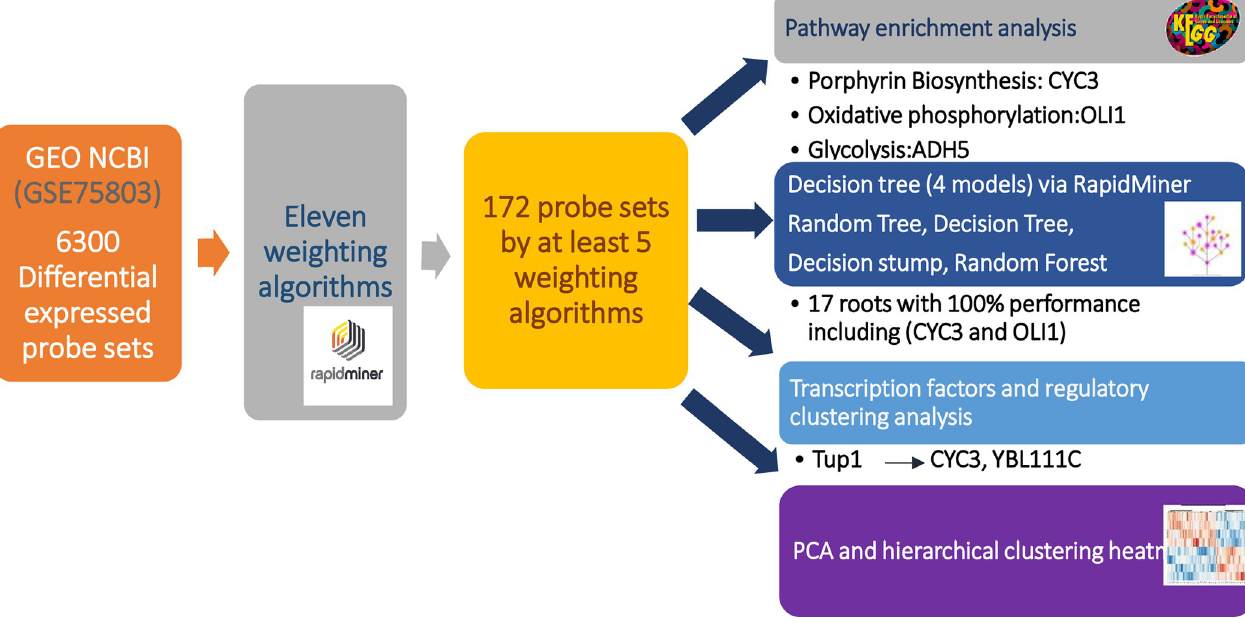
PLOS ONE | https://doi.org/10.1371/journal.pone.0259476 July 26,